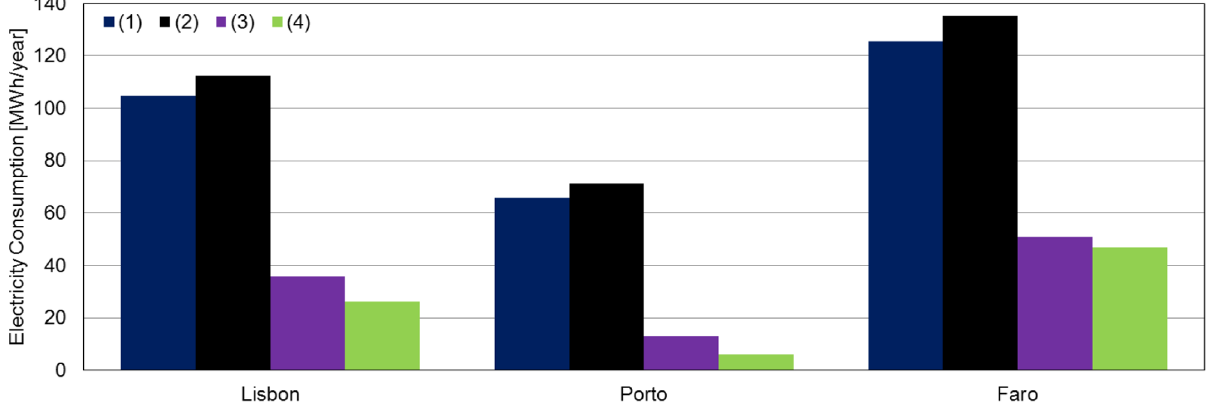
Fig. 5. Average annual electricity loads for